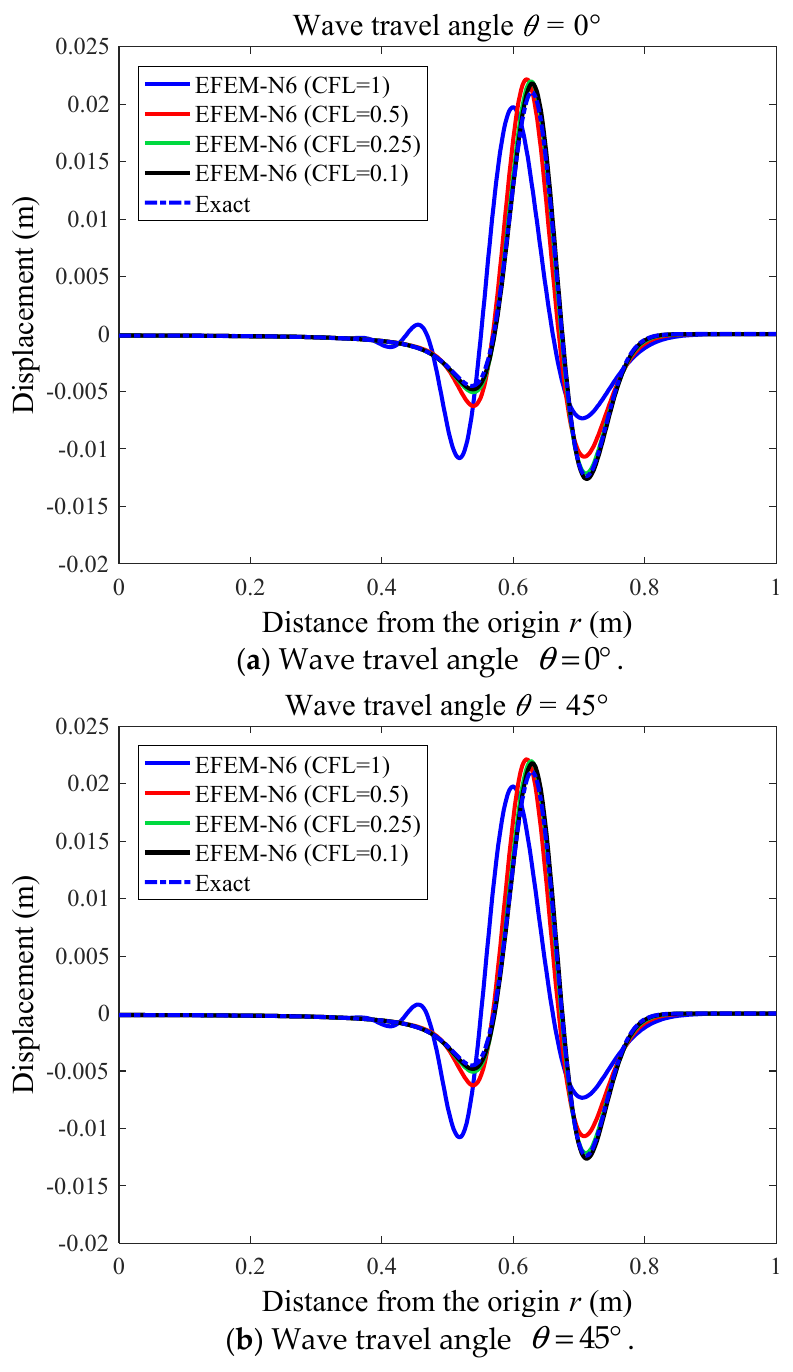
Figure 12. The displacement responses of the square membrane from the EFEM-N6 by varying the employed nondimensional temporal discretization interval.